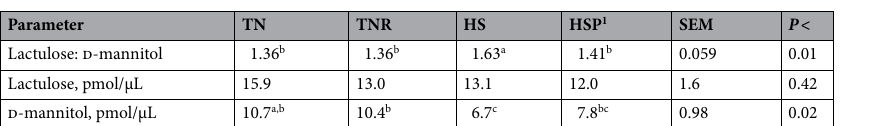
Table 2. Intestinal permeability increased in HS but not in the HSP Holstein bull calves (n = 8 per treatment). TN thermoneutral, TNR thermoneutral feed-restricted, HS heat stress, HSP heat stress-postbiotic, SEM standard error of the mean. a,b,c Values within the same row with different superscripts denote significance differences ( P < 0.05. 1 AO postbiotic fed at 3 g/calf/day and mixed with milk replacer.